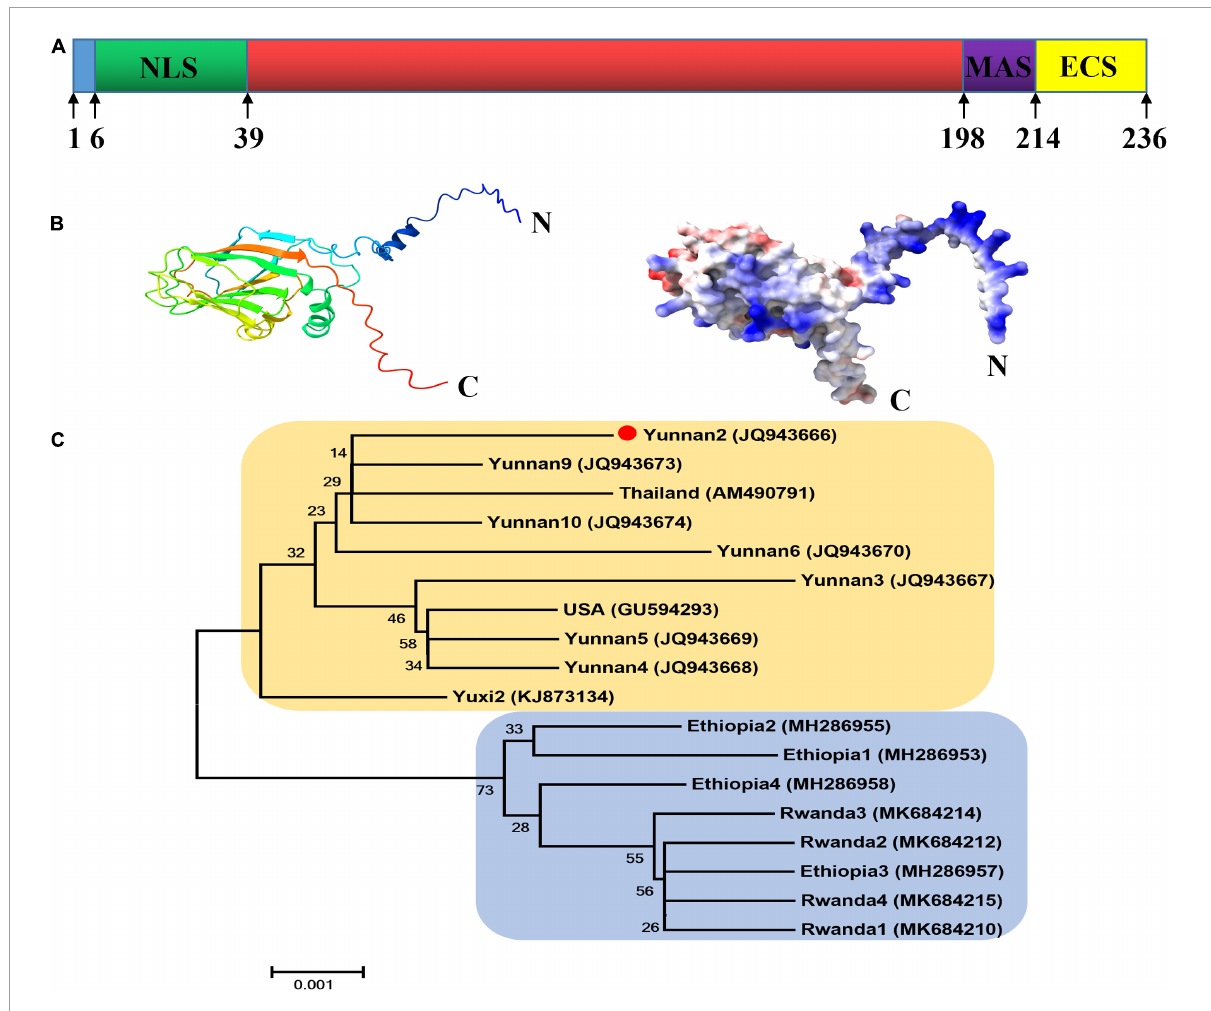
FIGURE1 Bioinformatic analysis of the p25 of maize chlorotic mottle virus (MCMV). (A) Domain arrangement of p25. NLS, nuclear localization sequence; MAS, membrane-anchored sequence; ECS, extracellular sequence. Special function domains are represented with different colors. (B) Structural model analysis using SWISS-MODEL software. (C) Phylogenetic tree of CP nucleotide sequences in MCMV. The phylogenetic tree was constructed with MEGA5.22 software using the neighbor-joining